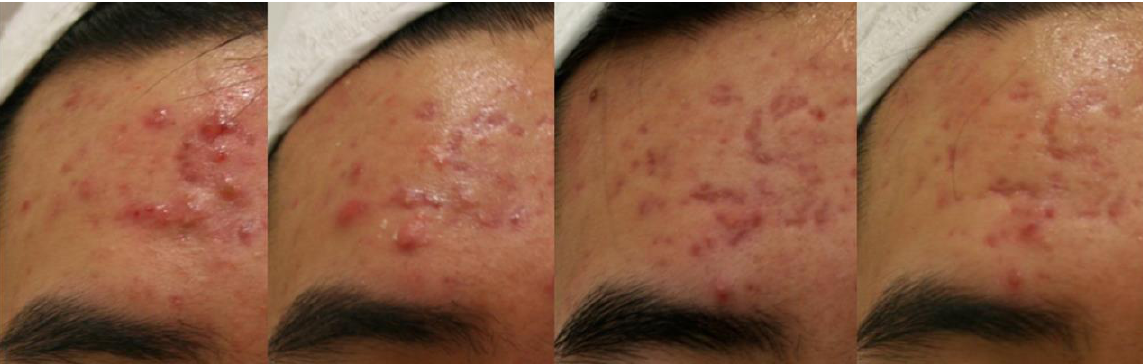
Figure 4. Improvement of inflammatory papules and superficial cysts on the forehead of a Korean adolescent acne patient, after three sessions of local cryotherapy using a temperature-controlled cryotherapy device (TargetCool; RecensMedical, Ulsan, Korea). Permission and consent were given for the use of the photographs. Table 1. Summary table of the results of clinical studies.